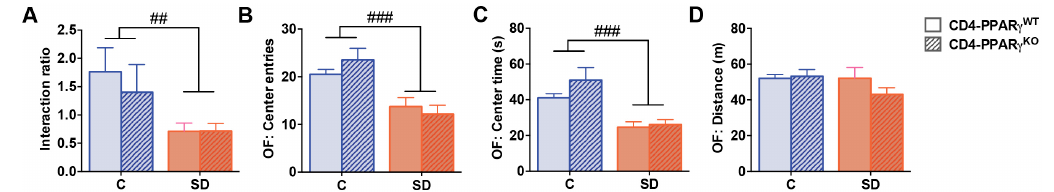
Figure 6. Behavioral data of CD4-specific PPAR γ knockout (CD4-PPAR γ KO ) mice and Cre-negative floxed controls (CD4-PPAR γ WT ) after 10 days of social defeat. ( A ) The interaction ratio of the social interaction test. ( B ) The number of center entries, ( C ) the time spent in the center, and ( D ) the distance traveled in the open-field test. Data represent mean + SEM. CD4-PPAR γ WT Control (C): n = 6, CD4-PPAR γ WT social defeat (SD): n = 11, CD4-PPAR γ KO Control: n = 6, CD4-PPAR γ KO SD: n = 8, ##: main effect of stress, p < 0.01, ###: p < 0.001.